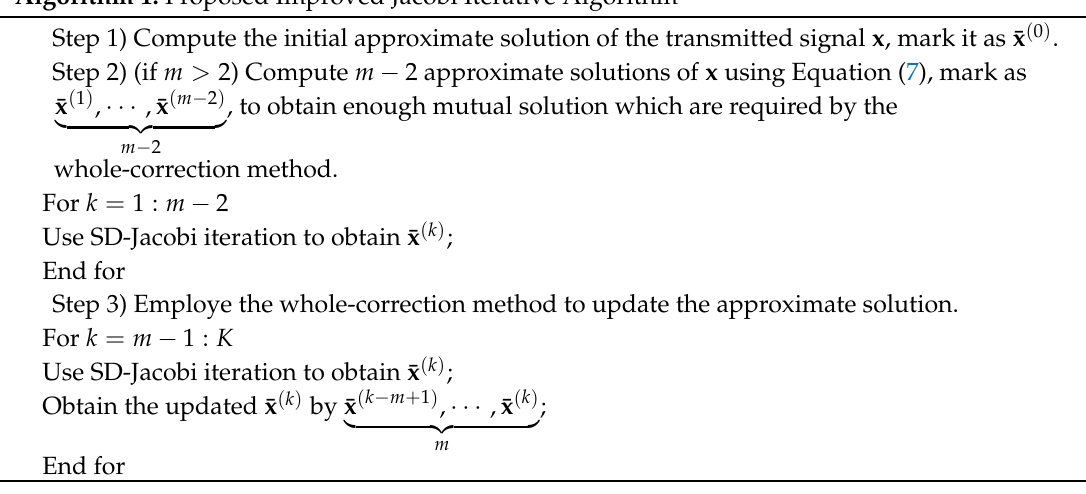
Algorithm 1: Proposed Improved Jacobi Iterative